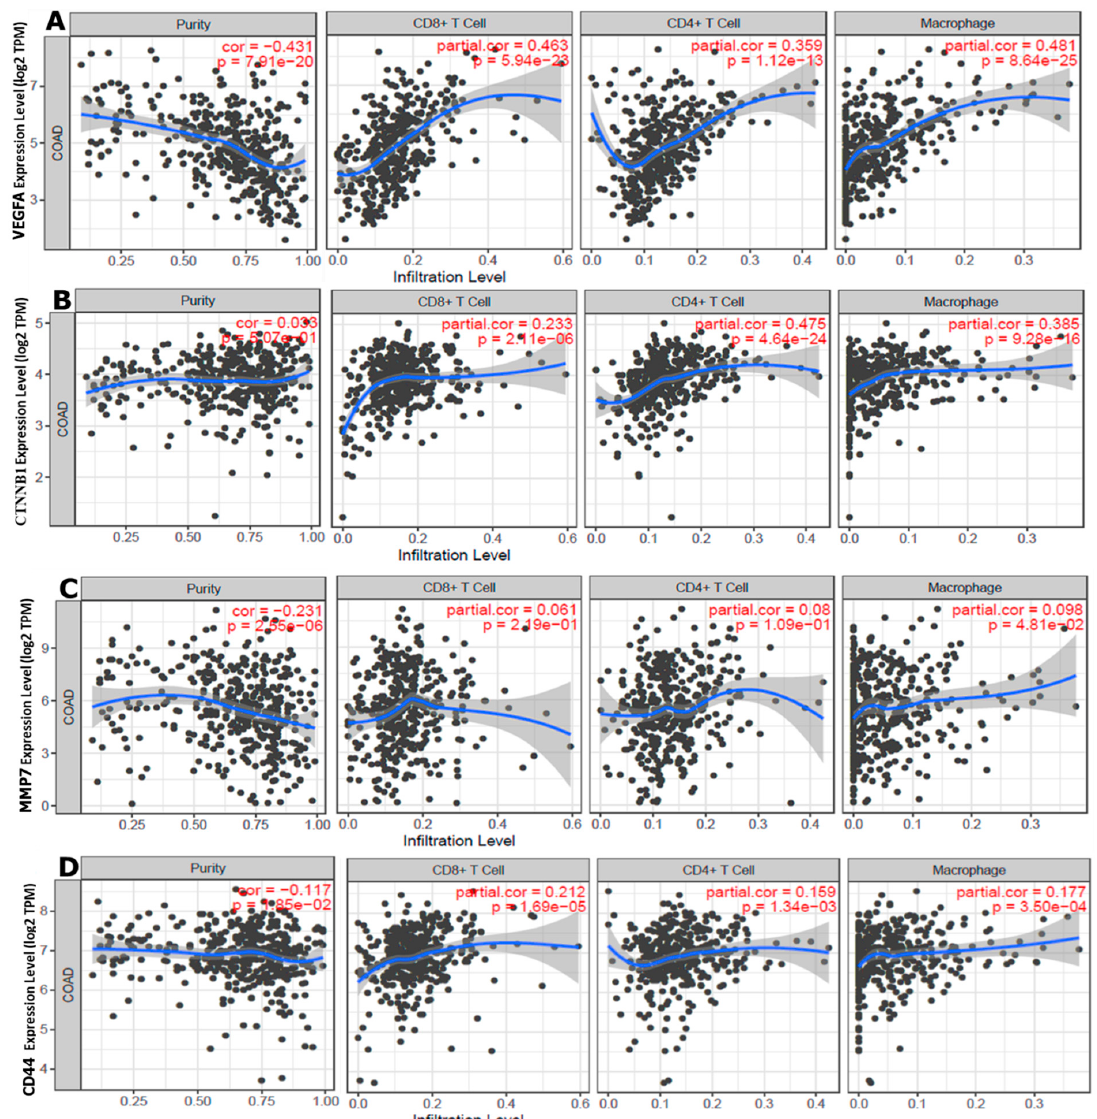
Figure 8. Correlation of vascular endothelial growth factor- α ( VEGFA )/beta catenin ( CTNNB1 )/matrix metalloproteinase ( MMP7) /cluster of differentiation 44 ( CD44 ) expression with immune infiltrating cells in (COAD). ( A ) VEGFA , ( B ) CTNNB1 , ( C ) MMP7 , ( D ) CD44 , and expression levels display associations with tumor purity and were positively correlated with lower infiltrating levels of CD8 + T cells and CD4 + cells, and a high infiltration level of M2 macrophages. The infiltration level was compared to the normal level using a two-sided Wilcoxon rank-sum test; p values of <0.05 were deemed